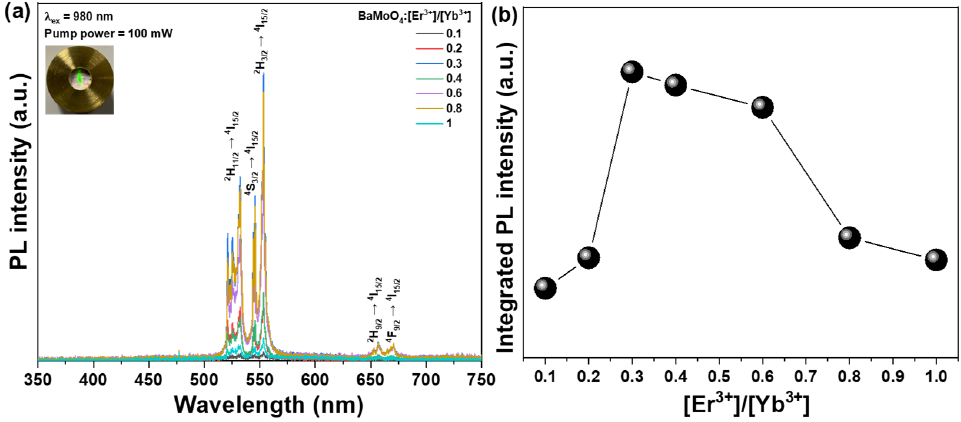
Figure 4. ( a ) PL spectra, and ( b ) change in PL intensity based on the Er 3+ concentration under 980 nm at 100 mW in the BaMoO 4 :[Er 3+ ]/[Yb 3+ ] up-conversion